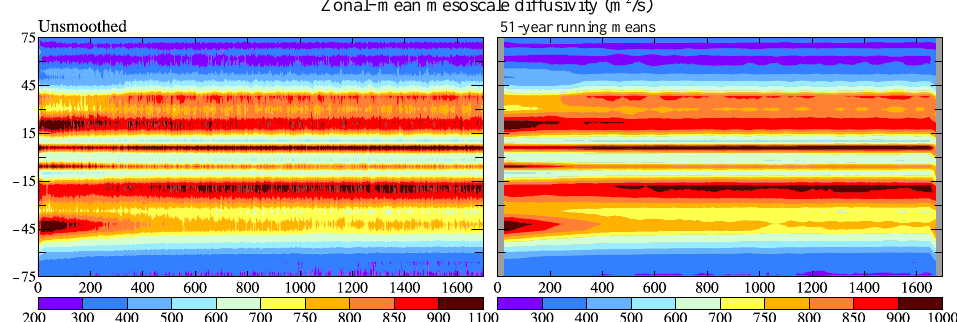
Figure 1. Zonal-mean mesoscale diffusivity (m 2 s − 1 ) versus time in control run.